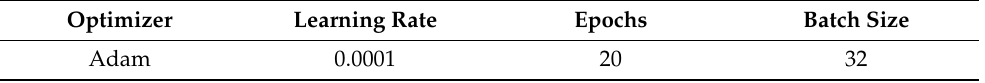
Table 6. Parameters for the training procedure of the MLP and FS networks in our